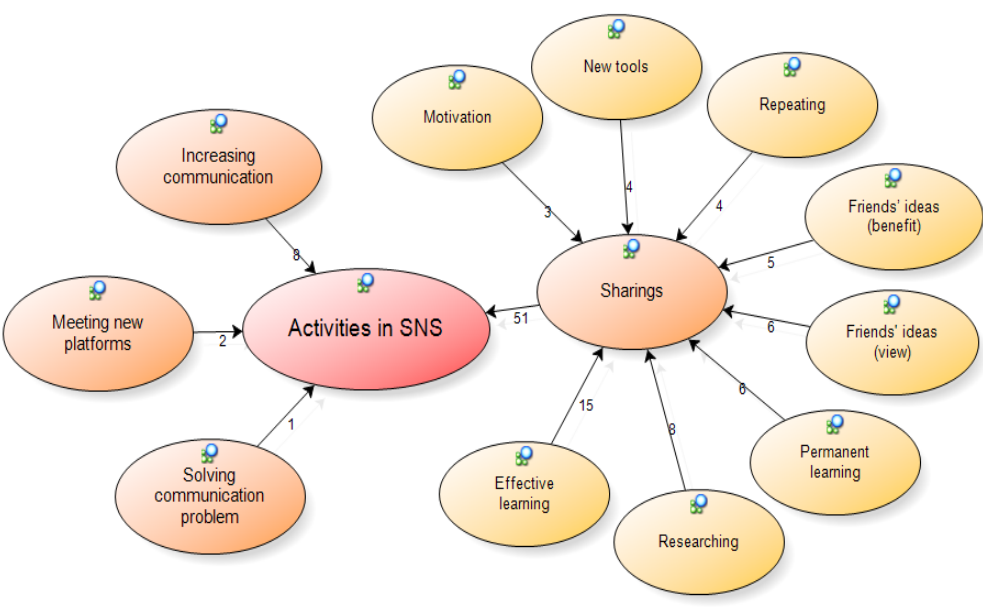
Figure 2. The model related to the participation in activities in the social networking